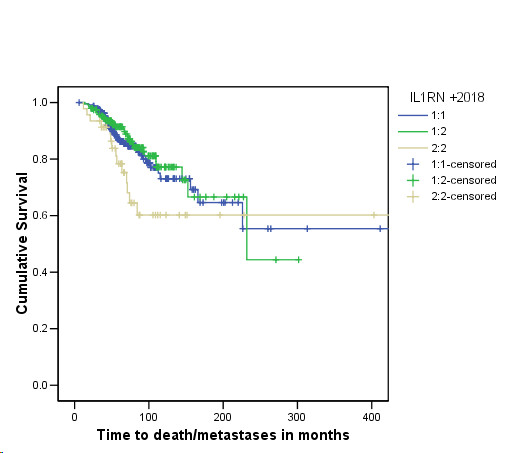
shows the time to death or metastases in invasive breast cancer for the genotypes of the IL1RN +2018 polymorphism. Log Rank test statistic = 4.32; df = 2; p = 0.12 (n = 481).